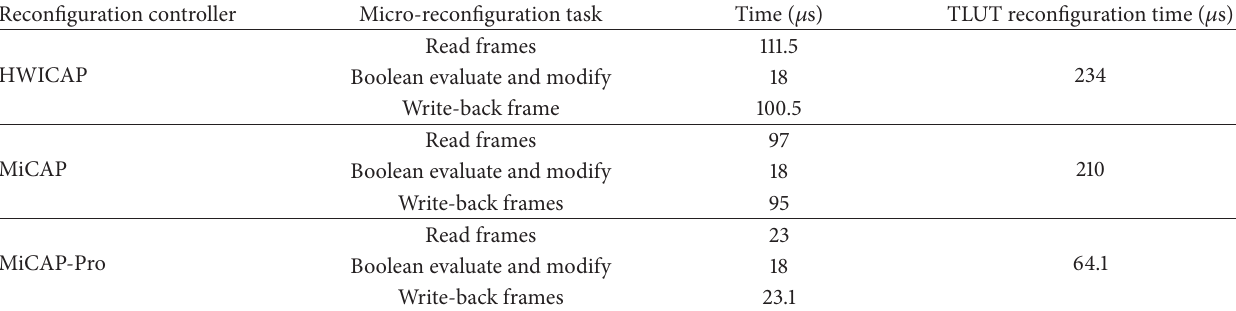
Table 4: Reconfiguration time distribution of a single TLUT.